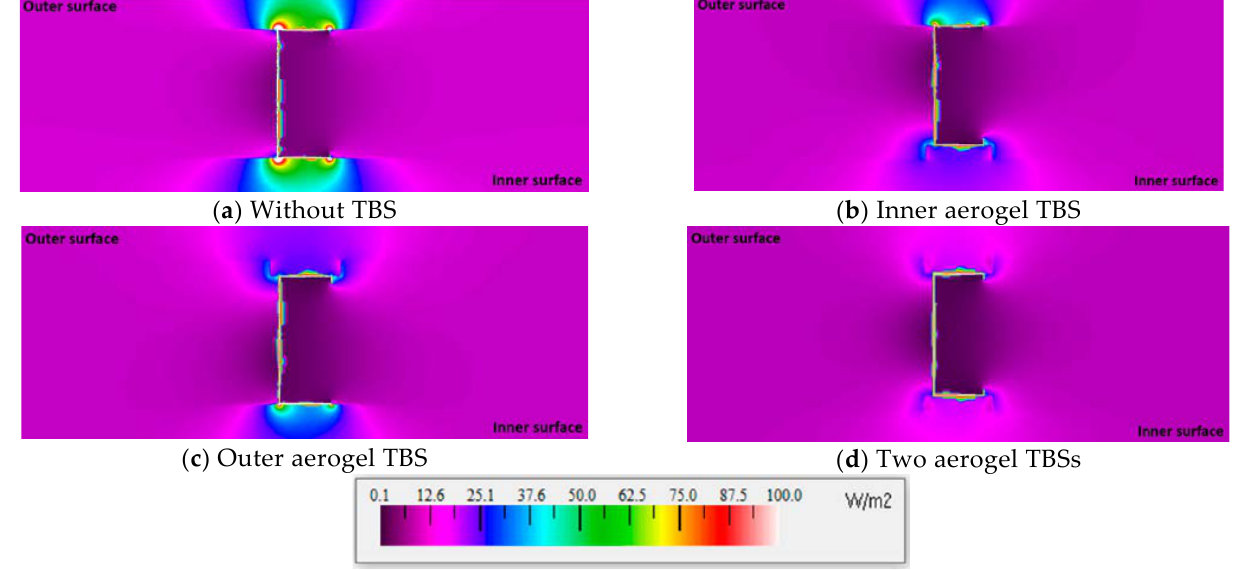
Figure 9. Heat flux distribution predicted for the LSF wall cross-sections.